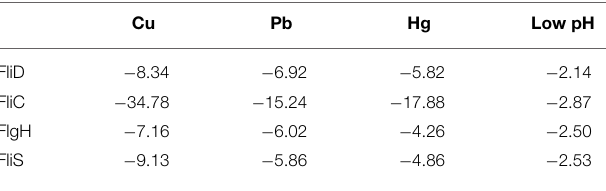
Frontiers in Cellular and Infection Microbiology |